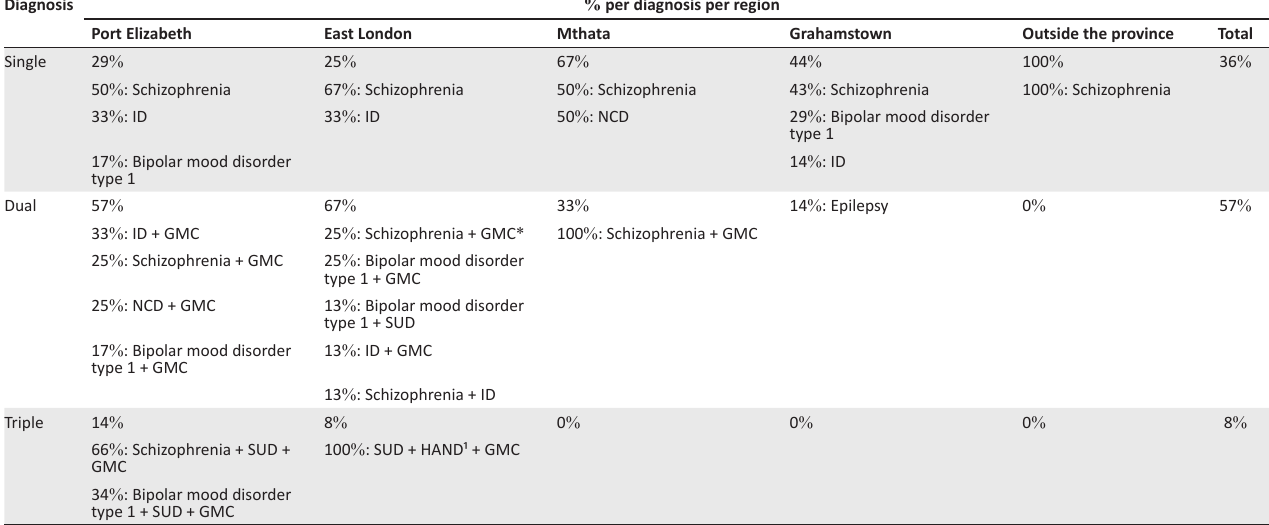
TABLE 4: Diagnosis of female patients on admission to Tower Psychiatric Hospital and Psychosocial Rehabilitation Centre. Diagnosis Port